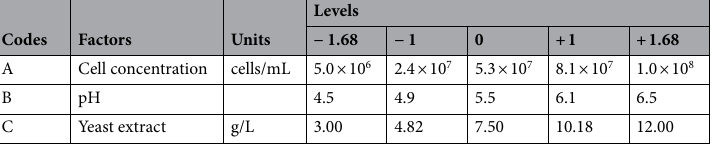
Table 6. Codes and actual values of the independent factors for CCD on ethanol production from PWH using S. cerevisiae HG1.1.